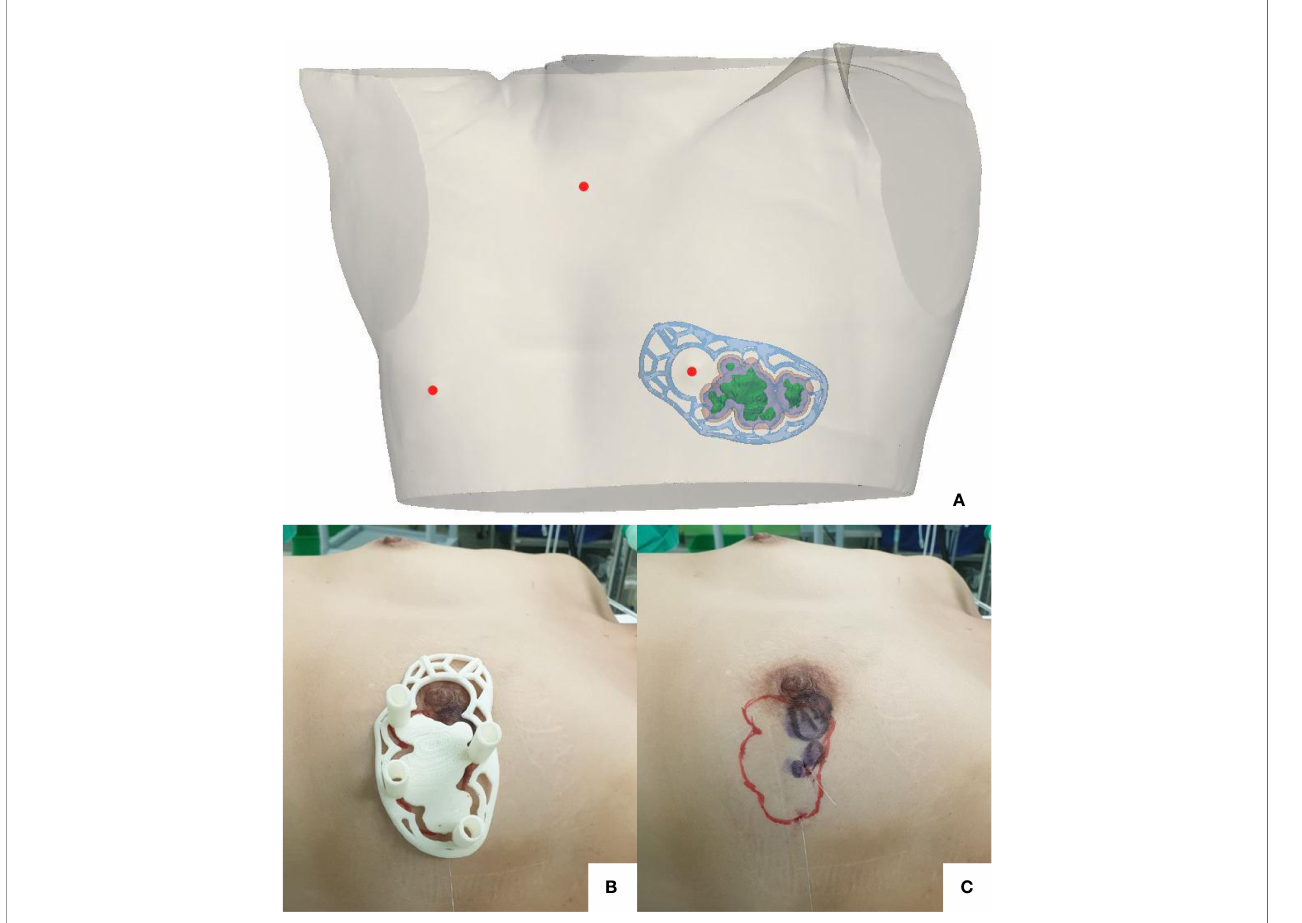
FIGURE 3 | The breast surgical guide (BSG) targeted the original tumor region by combining pretreatment prone magnetic resonance imaging (MRI)-generated tumor data and posttreatment supine MRI-generated breast data (A) . The BSG was manufactured as a hybrid type, containing a groove for marking the original tumor area on the breast surface with an extra 0.5 cm from the tumor boundary to guarantee safe margins. Blue dye injection columns were provided to indicate the extent of the tumor requiring removal (B) . A surgical resection line was drawn onto the breast skin surface along with a groove designed to match the original tumor area (C)